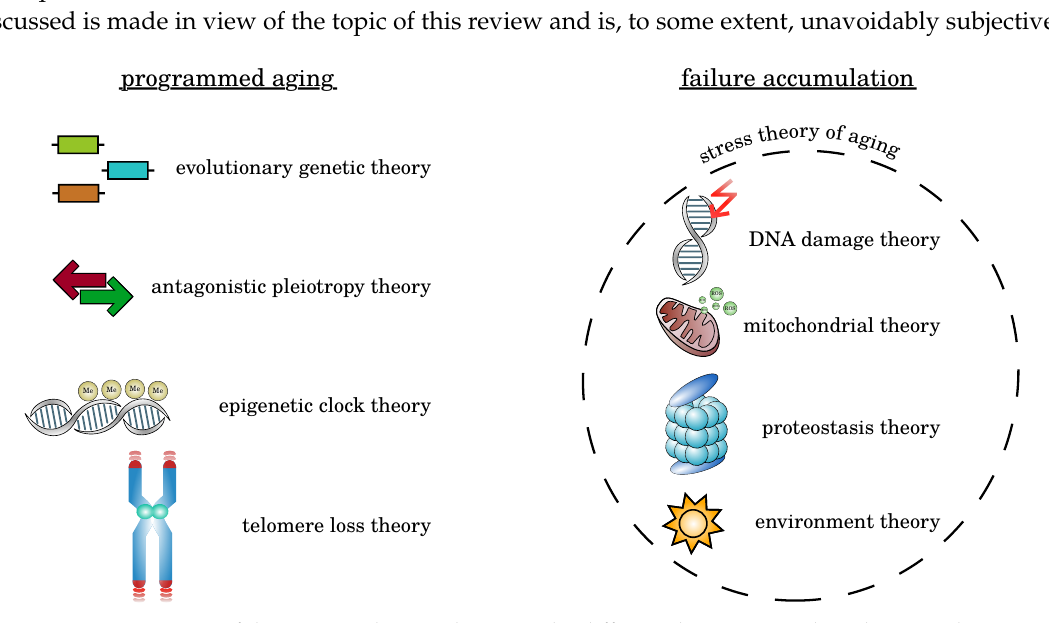
Figure 2. Overview of the presented aging theories. The different theories regarding the main driving factors of aging can be divided into two groups: programmed aging theories, stating that aging results from a genetic program (see Sections 2.1–2.5) and failure accumulation theories, stating that aging results from unavoidable, accumulating damage (see Sections 2.6–2.10). The collection of aging